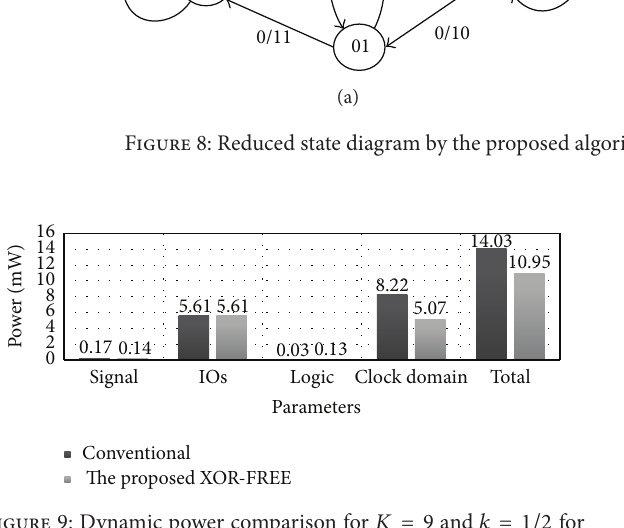
Figure 9: Dynamic power comparison for 𝐾 = 9 and 𝑘 = 1/2 for CDMA-2000